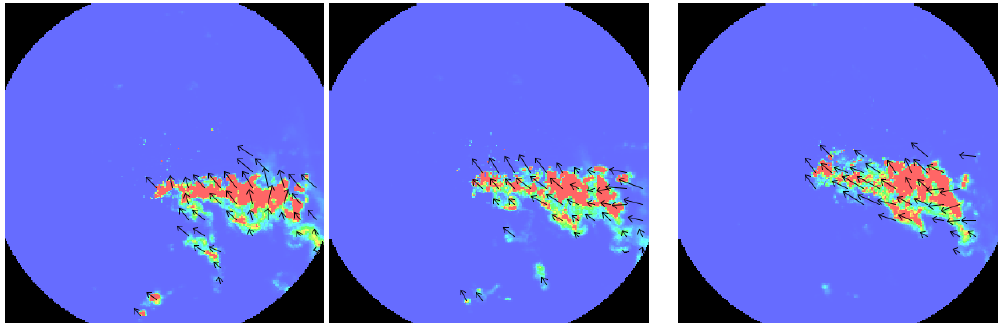
Figure 1. Time series of weather radar images (original size 230 × 230 pixels with a pixel resolution of 1 km 2 ) separated by 20 min from left to right. Motion vectors estimated with an optical flow